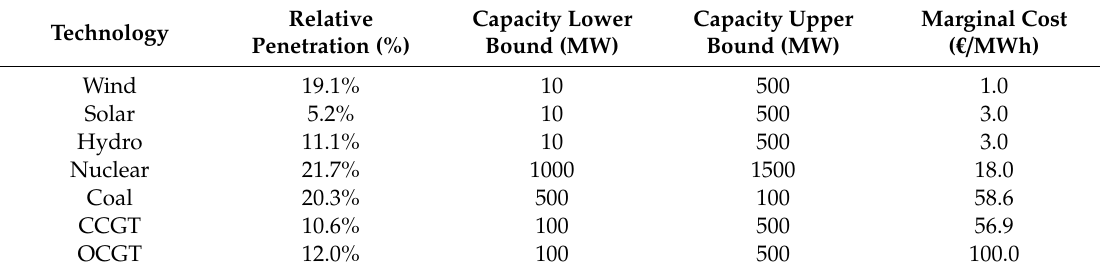
Table 1. Characteristics of